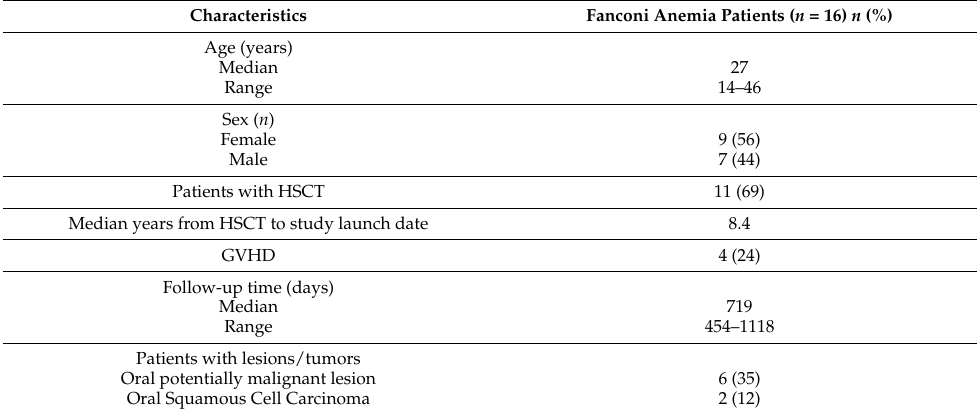
Table 1. Fanconi anemia patient cohort characteristics.